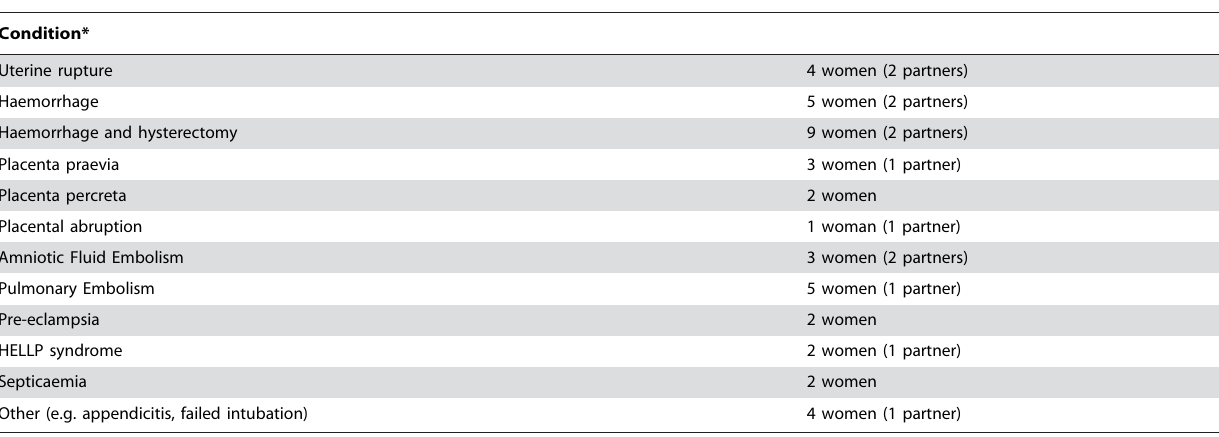
Table 1. Conditions experienced by women interviewed.